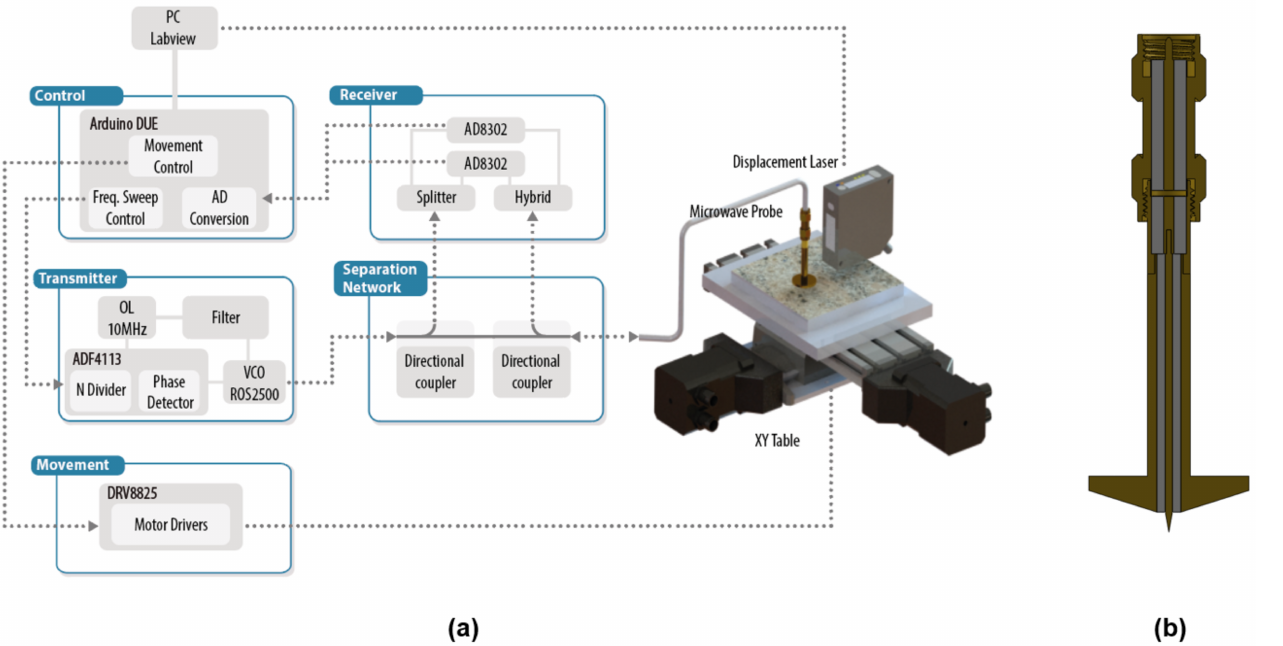
Figure 1. Schematic diagram of the near-field microwave microscope: ( a ) schematic diagram of the in-house vector network analyzer for measuring the reflection (S 11 ) of the near-field microwave microscope; ( b ) cross-section of the near-field coaxial